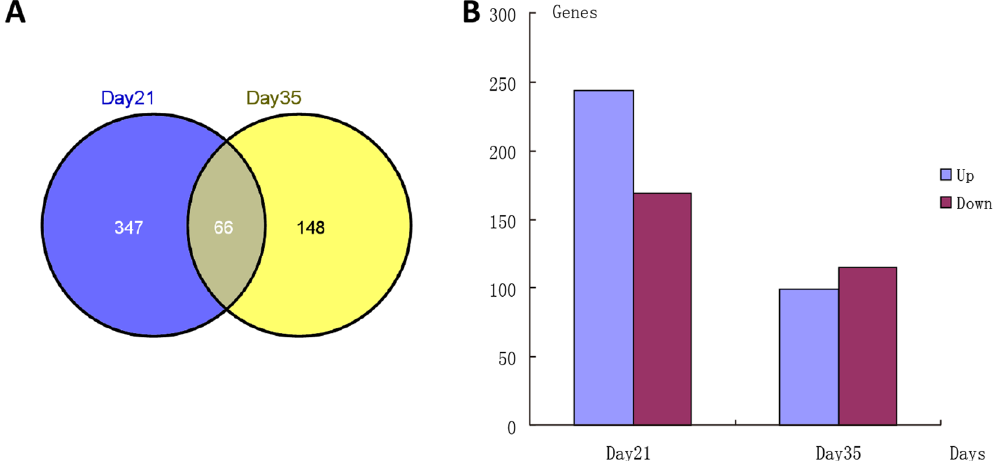
Figure 12. Comparison of differentially expressed genes (DEGs) in resistant and susceptible groups. Number of ( A ) DEGs and ( B ) upregulated and downregulated